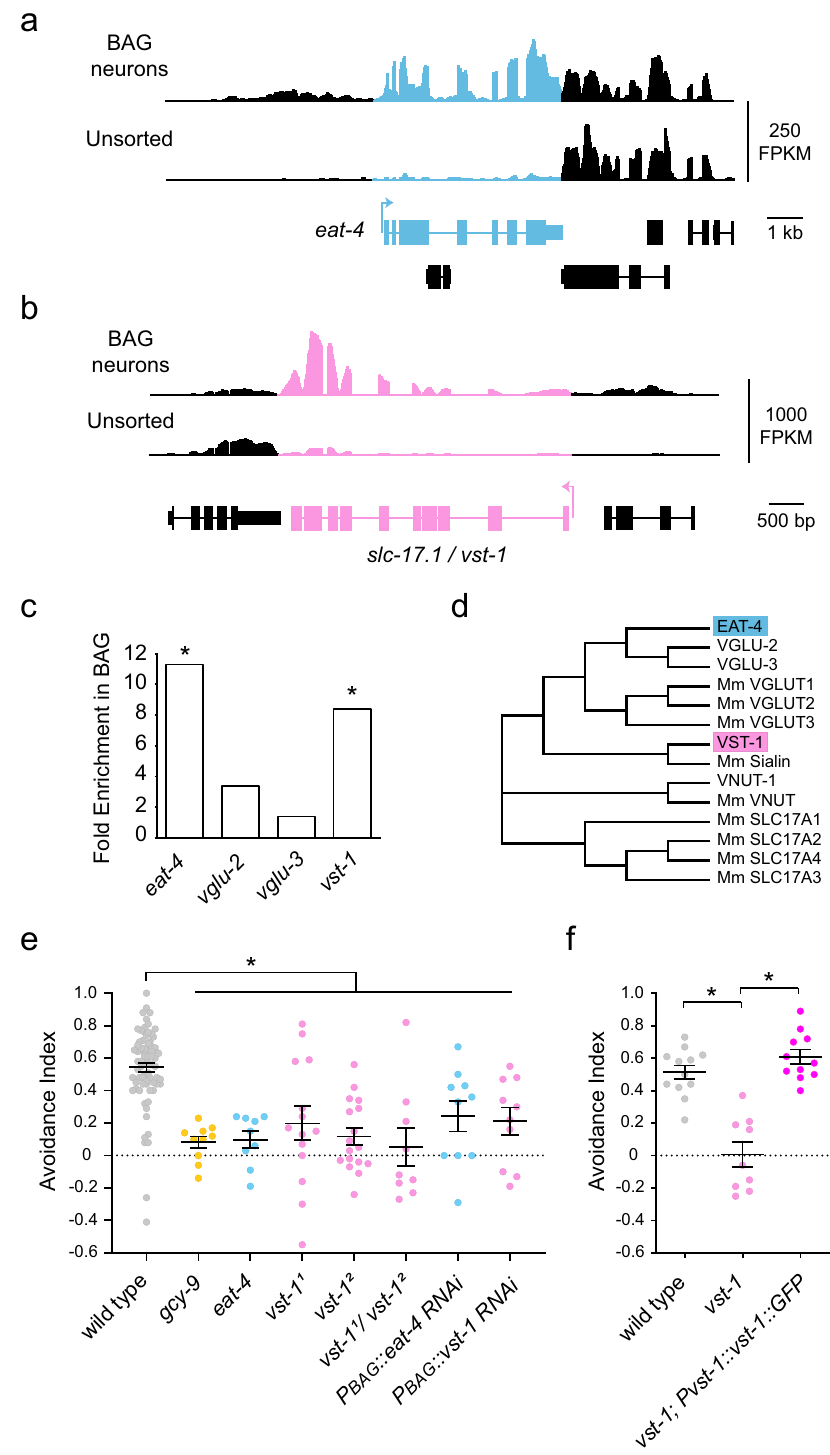
VST-1 is a synaptic vesicle transporter expressed in a majority of glutamatergic neurons . To determine which cells express vst- 1 , we generated a fosmid reporter that expresses nuclear mCherry in vst-1 -expressing cells (Supplementary Fig. 2b). We made transgenic animals carrying this reporter together with an eat-4 fosmid reporter that expresses nuclear yellow fl uorescent protein (YFP) in glutamatergic neurons 21 . These reporters revealed that vst-1 is expressed in many head neurons (Fig. 2a). Notably, a large majority of glutamatergic neurons in the head marked by the eat-